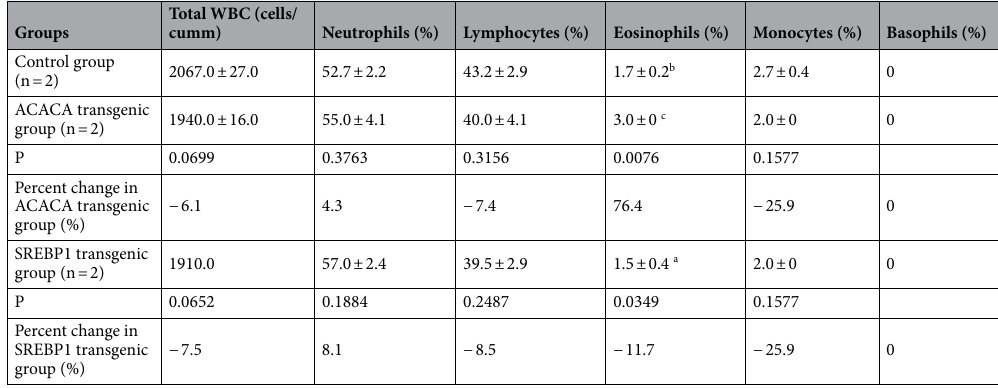
Table 5. Different blood cells (Mean ± standard deviation) in female transgenic and control birds at 26 weeks of age during 1st generation. Different superscripts (column-wise) indicate significant differences at P < 0.05. WBCs were counted in blood of transgenic as well as control birds at 26 weeks of age to compare between the groups.